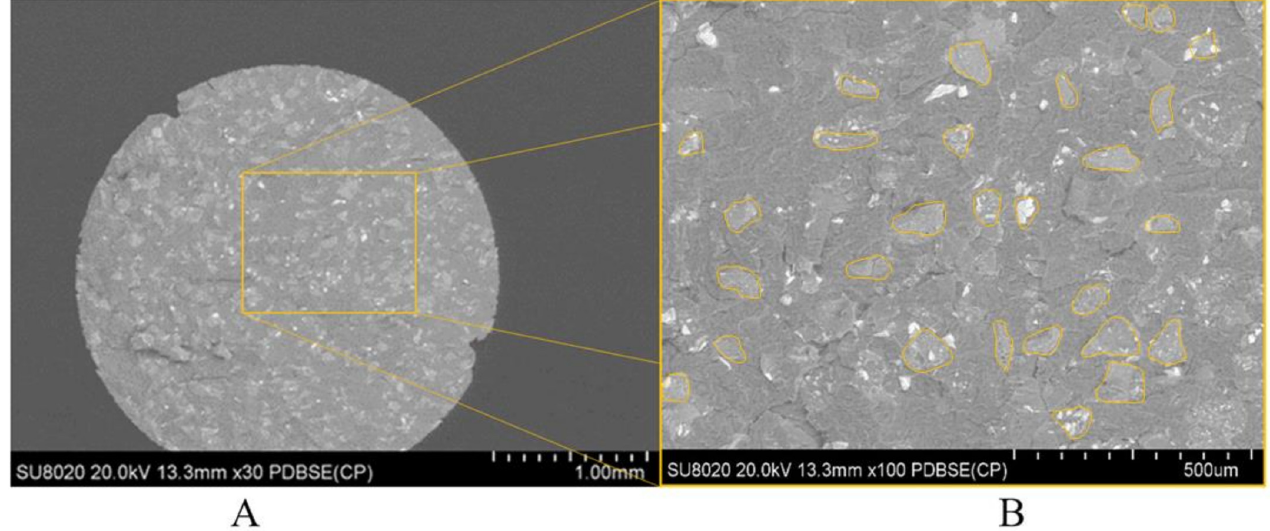
Figure 6. SEM micrographs of PA12/TR20 printed sample ( A ) and a micrograph detail revealing the TR particles distribution within the composite material (TR particles enclosed in orange) ( B